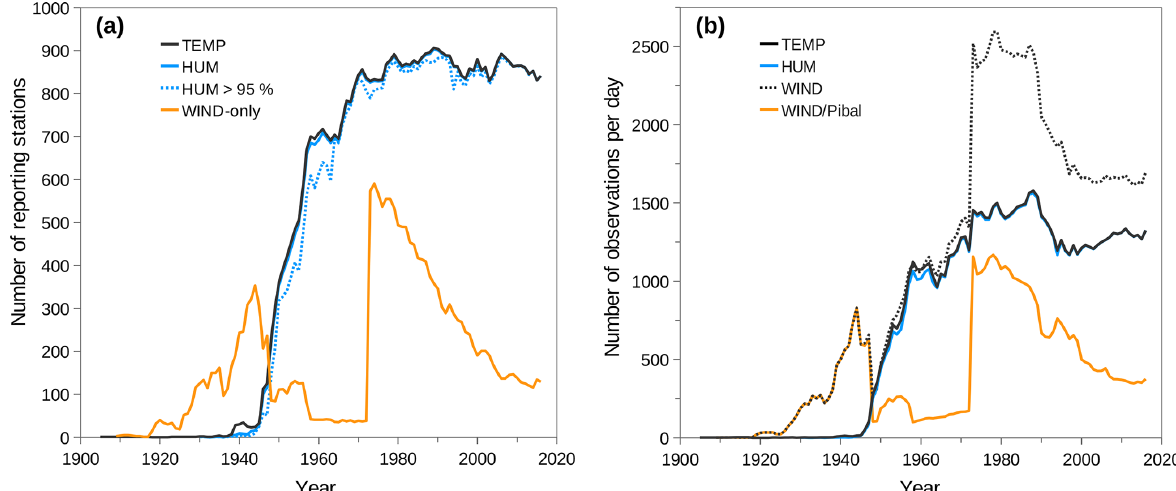
Figure 1. (a) Number of IGRA stations, for each year until 2016, reporting temperature observations, regardless of humidity and wind (TEMP); temperature and humidity observations, regardless of wind (HUM); humidity in at least 95% of the RAOBs (HUM > 95%); only wind observations (WIND-only). (b) Yearly average number of observations per day compiled in IGRA, by atmospheric parameter: temper- ature (TEMP); humidity (HUM); wind from radiosonde or pilot-balloon measurements (WIND); wind from pilot balloons (WIND/Pibal). Note: in panel (a) , the sum TEMP + WIND-only gives the global number of stations with any data in IGRA.